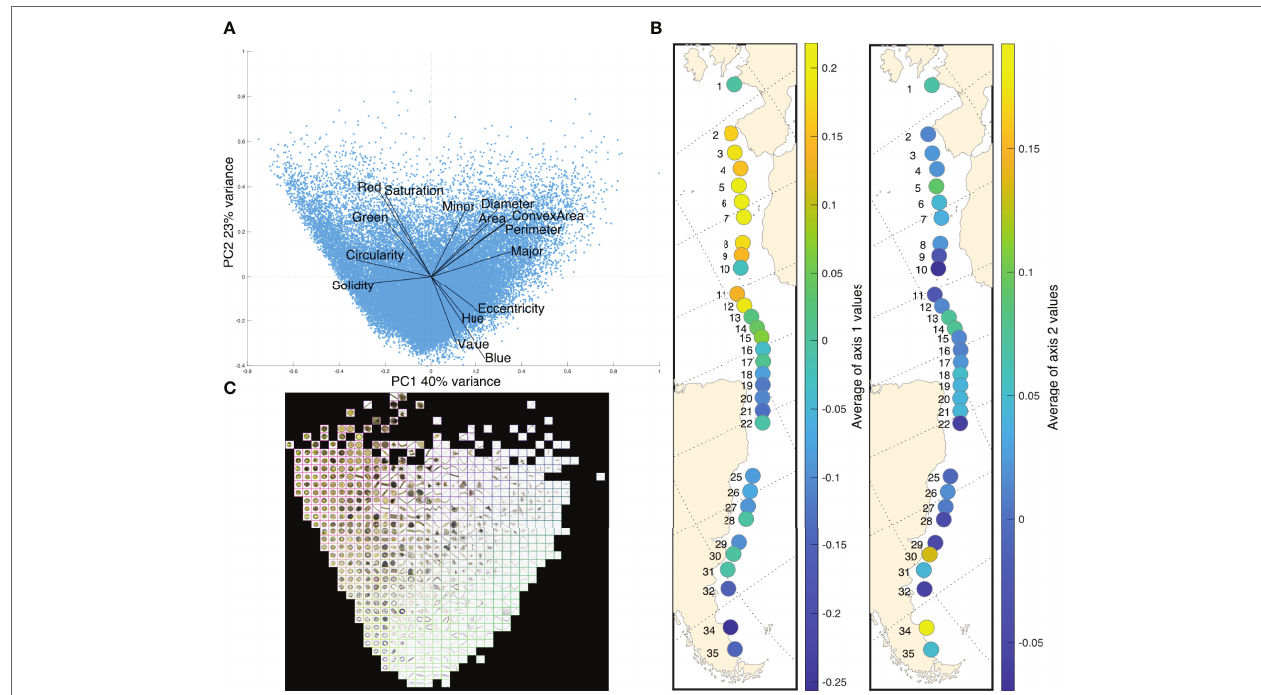
FIGURE 6 | (A) PCA performed on morphological variables characterizing the size, shape and color of microplankton (Euclidean distance). (B) Morphological characteristics of microplankton along the Tara Mission Microbiomes Atlantic transect, represented by morphometric (left side, PCA axis 1 values, average per station) and color (right side, PCA axis 2 values, average per station) features. (C) Representation of the PCA space by characteristic PlanktoScope